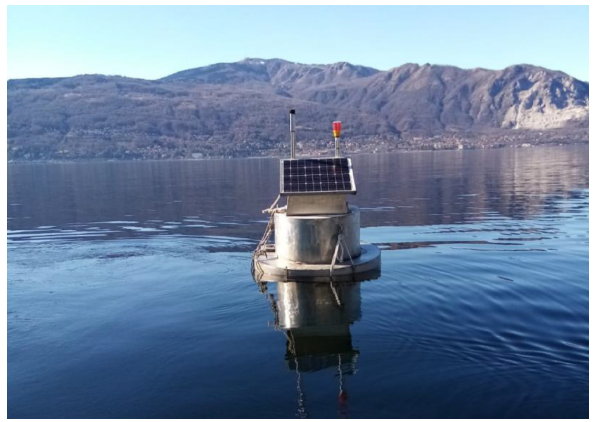
Figure 1: LM1 buoy in Maggiore lake